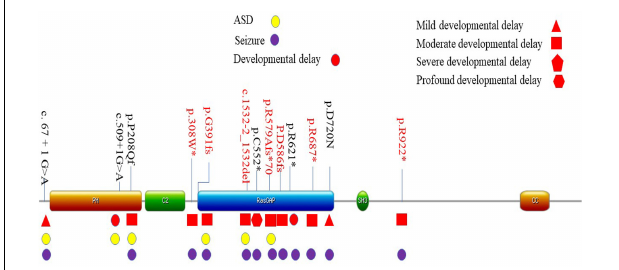
FIGURE 1 | Location of mutation sites of 13 patients in China. Localization of the SYNGAP1 mutations identified in Amino acid positions are based on the longest SynGAP isoform (NM_006772.3). The main phenotype was listed in corresponding domains. ∗ These variations caused truncated